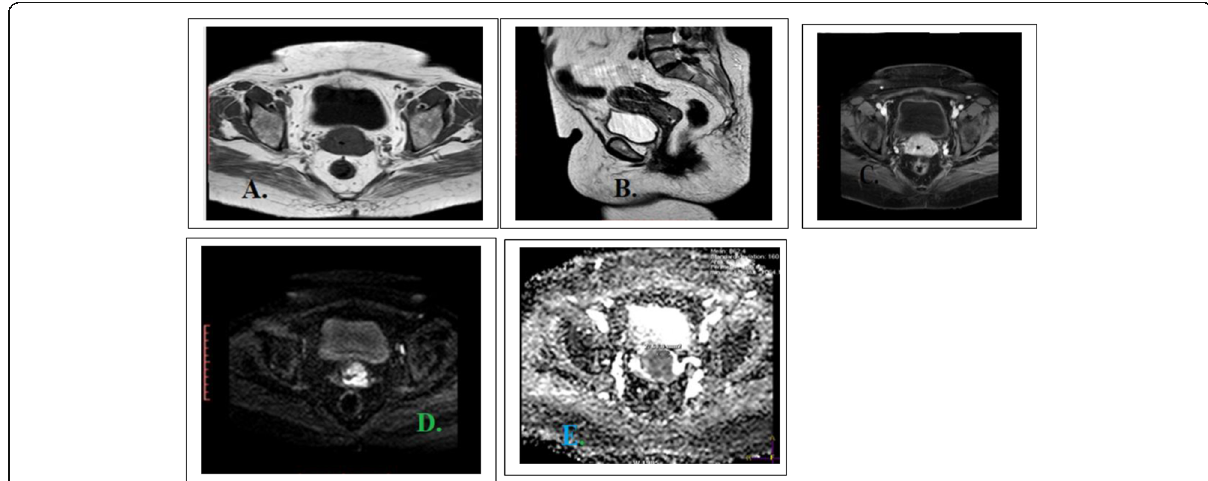
Fig. 1 Eighty-two-year-old female patient complaining of post-menopausal bleeding. a Axial T1WI revealed isointense cervical soft tissue mass lesion measuring 4 × 3.5 × 3 cm in (AP, transverse, CC) dimensions. b Sagittal T2WI showed relatively hyper intense signal. c Post-contrast axial image with heterogeneous enhancement. d High signal on DWI and low signal on the corresponding ADC maps ( e ). ADC value was (0.831 × 10 − 3 mm 2 /s). Finding suggestive of malignant lesion. Pathology revealed papillary